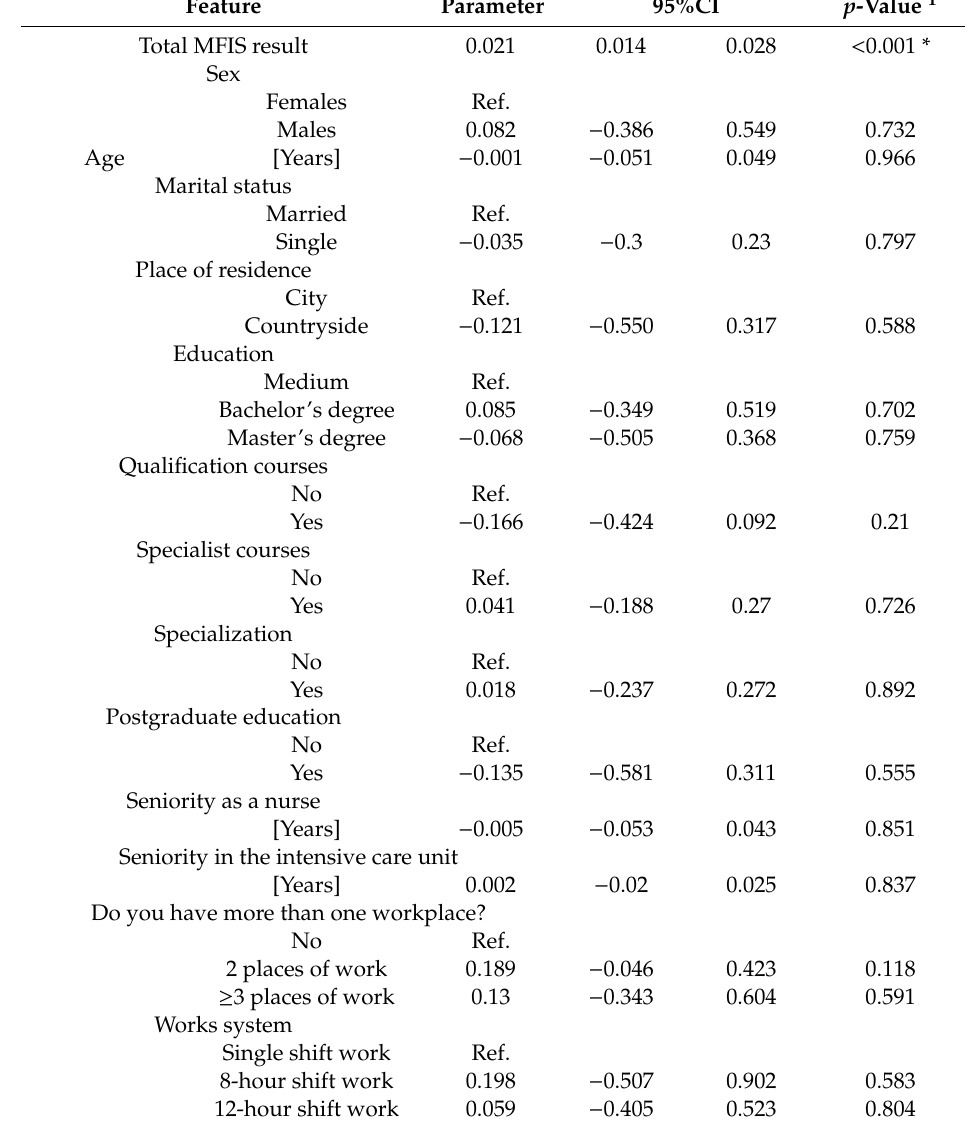
Table 4. The regression model and rationing of nursing care. Feature